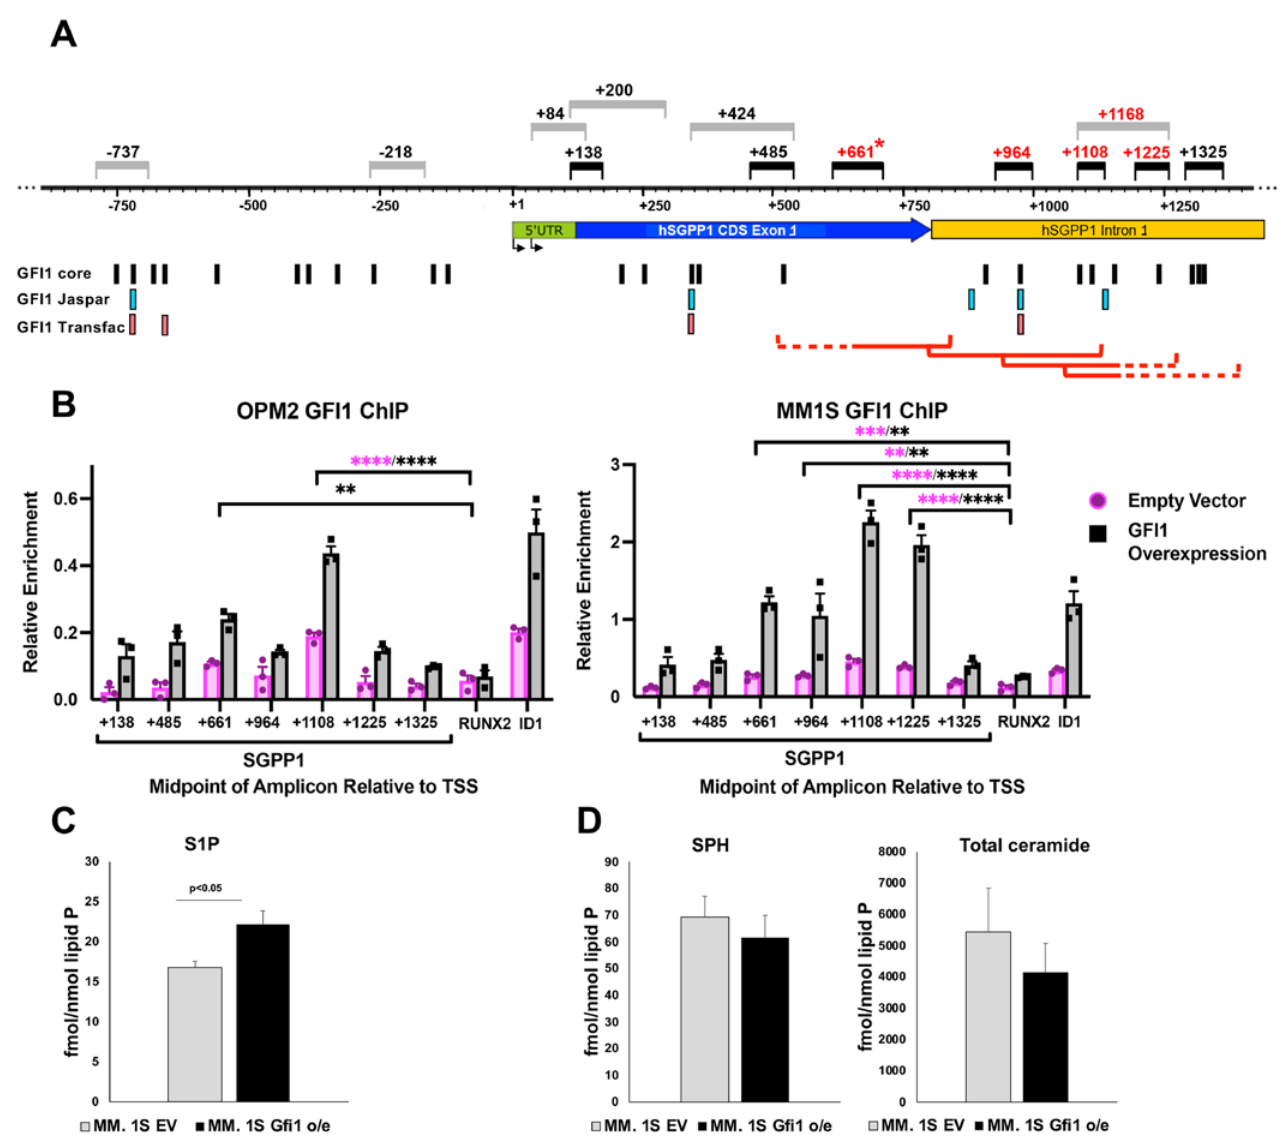
Figure 5. GFI1 ChIP-qPCR studies reveal GFI1 binding on SGPP1 in MM cells. A schematic of the promoter, exon 1, and part of intron 1 of human SGPP1 NM_030791.4 (GRCh38.p12; GCF_000001405.27) is presented below a nucleotide scale labeled with respect to the SGPP1 TSS (+1) at nucleotide 63,728,065. PCR amplicons (midpoints relative to SGPP1 TSS) used to analyze GFI1 ChIP-qPCR using 500-bp (Gray bars) or 200-bp (Black bars) chromatin fragmentation; red amplicon # has significant results in this study. * +661 amplicon was used in both screens. The predicted putative GFI1 binding sites found using searches for the GFI1 core AA(T/G)C; or the Jaspar; and Transfac algorithms are shown, along with red brackets that indicate the detection ranges of the positive amplicons (dashes; overlaps with the detection range of a negative amplicon). ( A ); Chromatin of OPM-2 (left panel) and MM.1S (right panel) cell lines, GFI1 o/e and EV control, which were fragmented to an average size of 200-bp. Sites on SGPP1 were compared to a background control amplicon on the RUNX2 gene (+66,065) and a positive control amplicon on the ID1 gene (+275). The primer sequences are indicated in Table S4 along with their detection ranges. Data show the mean of three biological replicates with the standard error. Statistical analyses used one-way ANOVA with Dunnett’s multiple comparisons correction comparing to “RUNX2” in the same cells: * p < 0.05; ** p < 0.01; *** p < 0.001; **** p < 0.0001. ( B ); Abundance of sphingolipid species: S1P ( C ); sphingosine (SPH) ( D -left panel) and total ceramide ( D —right panel) as measured by LC-MS/MS in MM.1S cells GFI1 o/e compared to their EV controls. Data are the average of three biological replicates (Mean +/ − SEM).